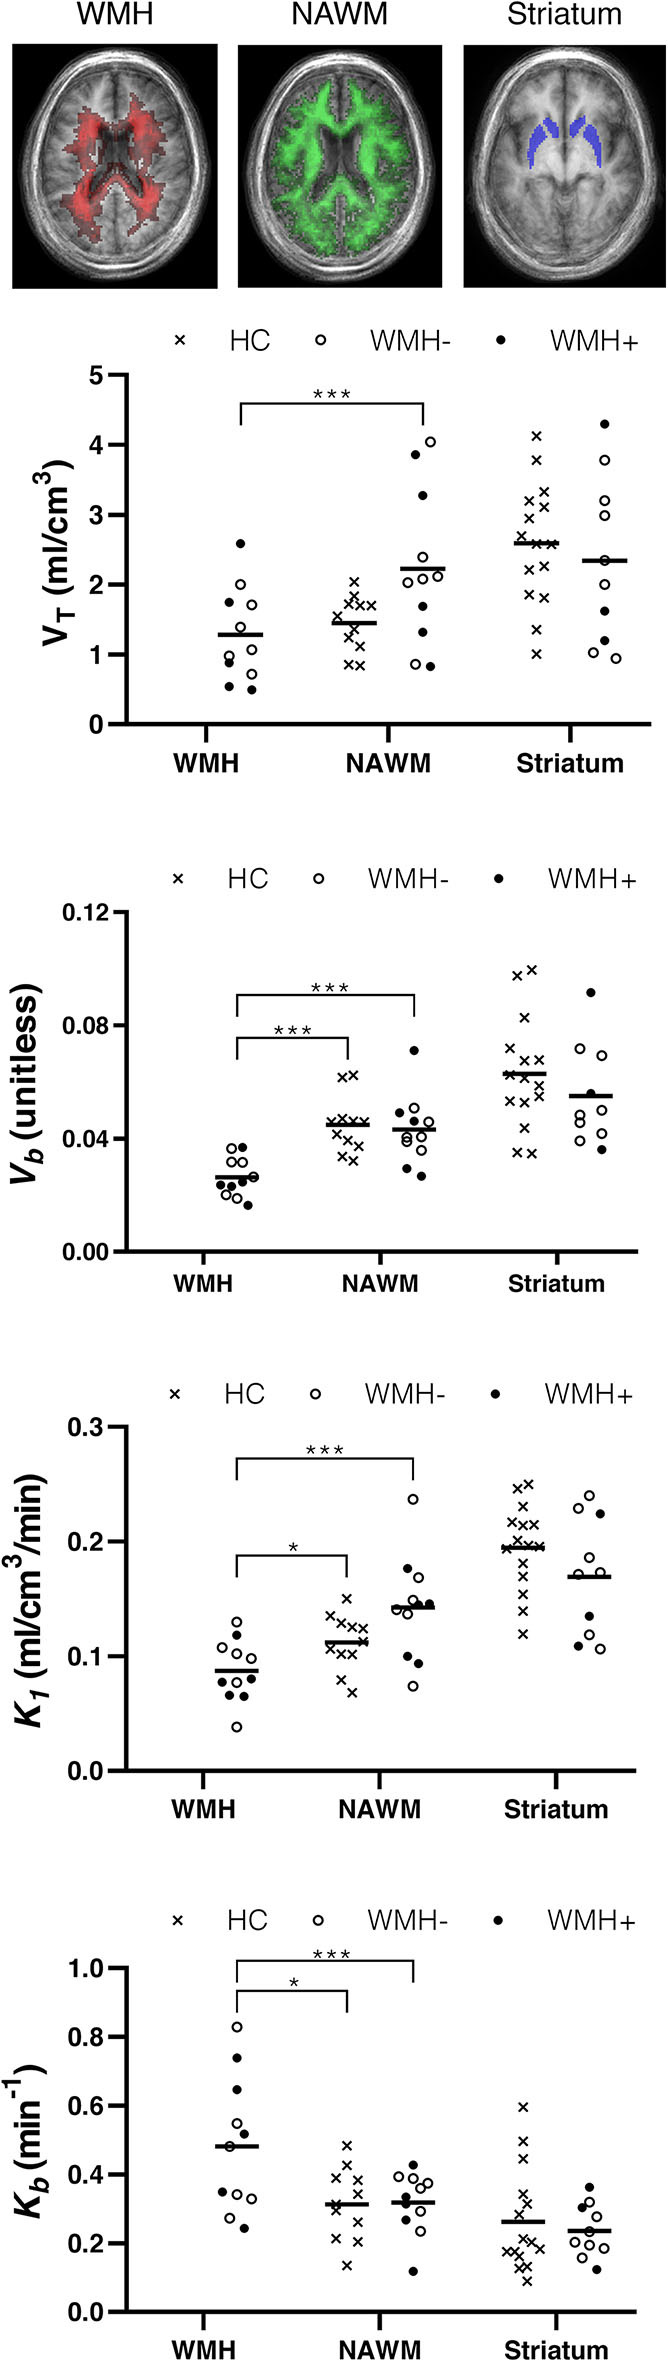
TSPO binding differs between normal appearing white matter (NAWM) and white matter hyperintensities (WMH). Top row: group frequency maps of WMH (red) and NAWM (green) with voxel intensity indicating number of participants with corresponding tissue type, and the atlas region defining the striatum (blue). Plots show volume of tracer (VT), tissue-to-blood ratio (Vb), plasma to tissue tracer transport (K1), and vascular-bound tracer (Kb) for individual participants. Crosses represent healthy controls (HC). Filled and hollow circles represent individuals in the SVD group with (WMH+) or without (WMH–) a history of lacunar stroke. Horizontal line: mean. *p < 0.05 and ***p < 0.001.